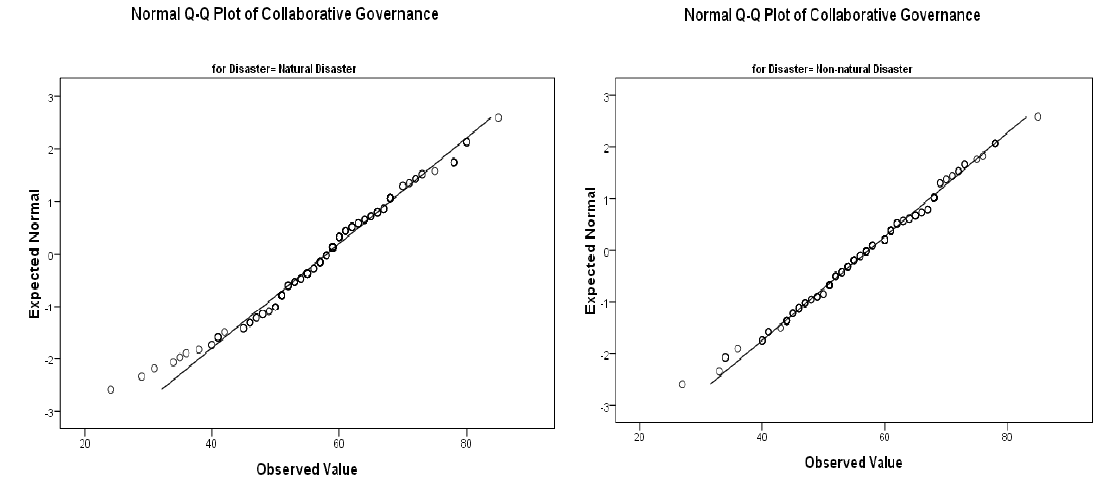
Figure 2. Normal Q-Q